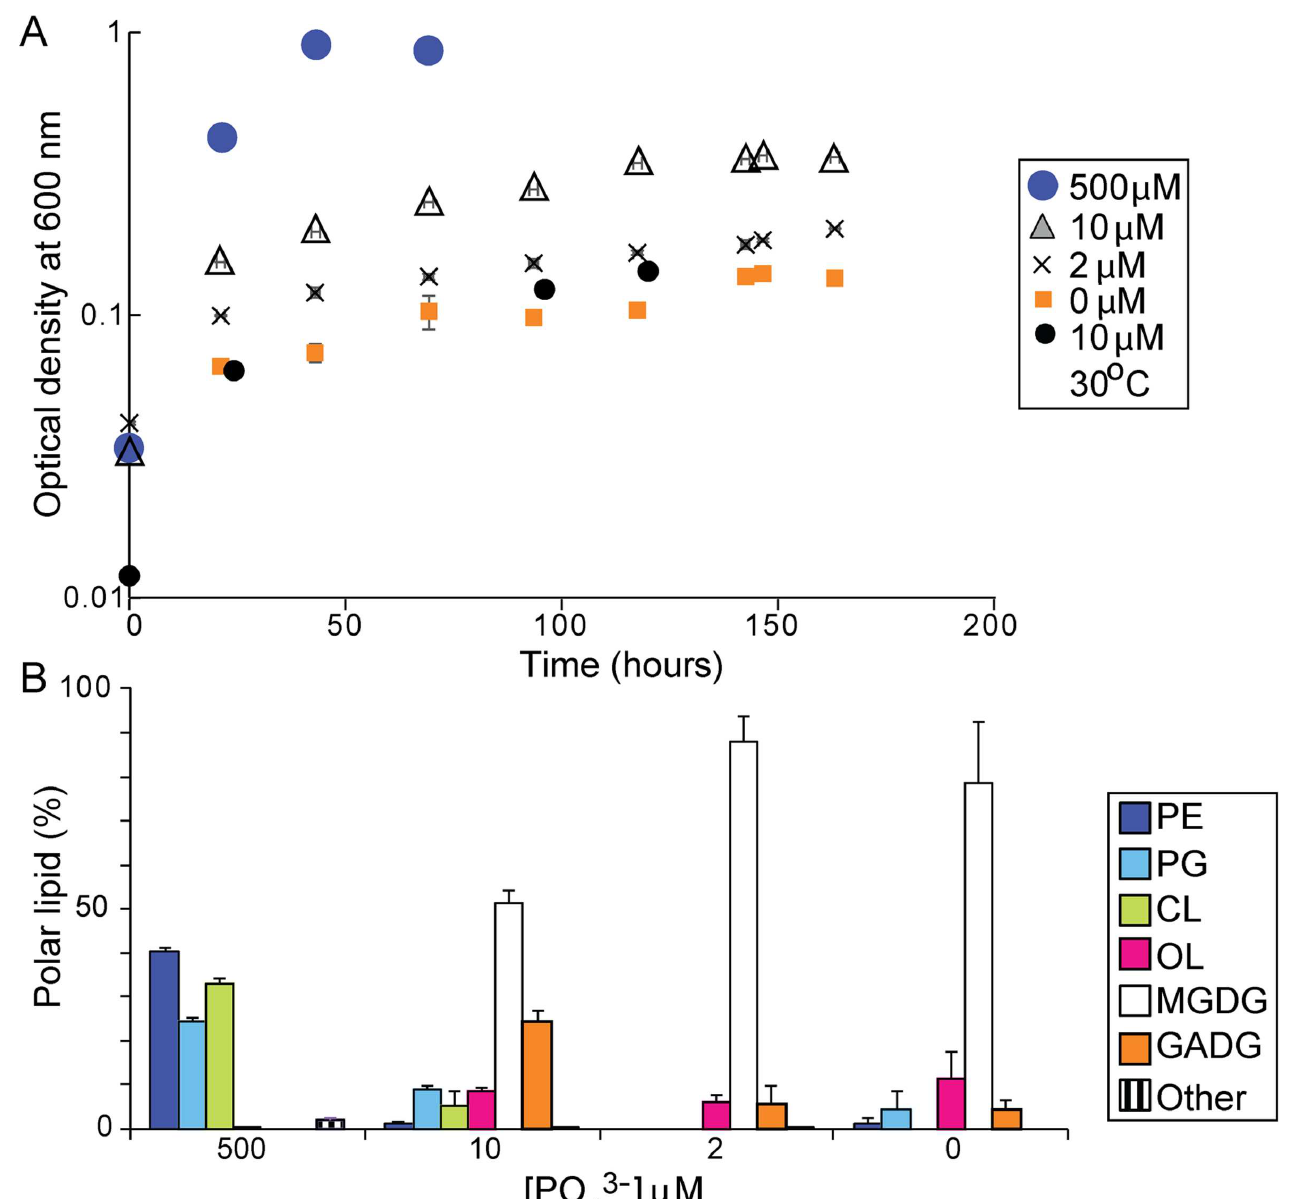
Fig 1. Growth and lipid composition of G20 in media with different initial concentrations of phosphate. (A) Growth at 37˚C in duplicate cultures with different initial concentrations of phosphate in the medium and growth at 30˚C with 10 μ M initial phosphate. (B) The compositionof polar lipids in duplicatecultures of G20 grown at 37˚C with 500, 10, 2 and 0 μ M initial phosphate. PE: phosphatidylethanolamine, PG: phosphatidylglycerol, CL: cardiolipin, OL: ornithinelipids, MGDG: monoglucosyl diacylglycerol, GADG: glycuronic acid diacylglycerol, Other: includes N -acetyl-PE, N -acyl-PEand two unidentified lipids with head group losses of 199 Da and 213